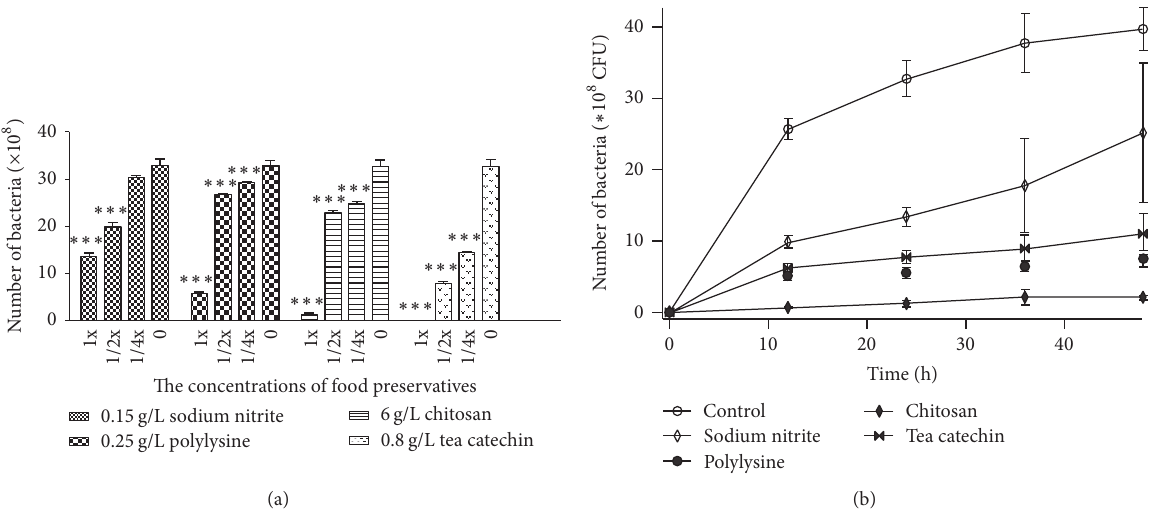
Figure 1: Viable plate count of penicillin-resistant S. aureus strain H4 treated with different food preservatives. (a) 2 × 10 5 CFU S. aureus H4 was inoculated in 250 mL TSB medium supplemented with 0.15g/L (1x), 0.075 g/L (1/2x), or 0.0375 g/L (1/4x) sodium nitrite; 0.25 g/L (1x), 0.125 g/L (1/2x), or 0.0625 g/L (1/4x) polylysine; 6g/L (1x), 3g/L (1/2x), or 1.5g/L (1/4x) chitosan; and 0.8 g/L (1x), 0.4 g/L (1/2x), or 0.2 g/L (1/4x)tea catechin, respectively. After incubation at 37 ∘ Cfor24 hours,1 mLcell suspensionwas collected for viableplate count. (b)2 × 10 5 CFU S. aureus H4 was inoculated in 250 mL TSB medium supplemented with 0.15 g/L sodium nitrite, 0.25 g/L polylysine, 6g/L chitosan, or 0.4 g/L tea catechin for 12, 24, and 48 hours, respectively. Data were the mean ± SEM of three independent experiments ( ∗∗∗ 𝑝 < 0.001 ).